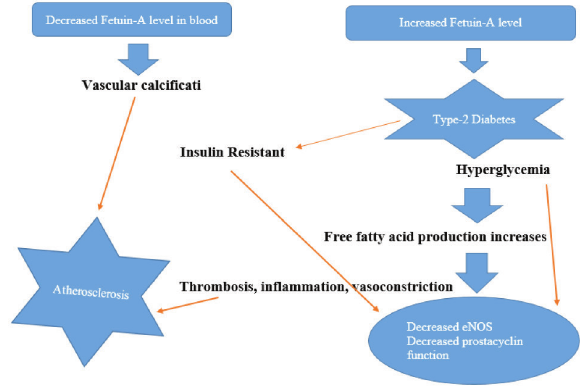
Figure 2 . The association of fetuin-A with type 2 diabetes, vascular calcification and atherosclerosis.